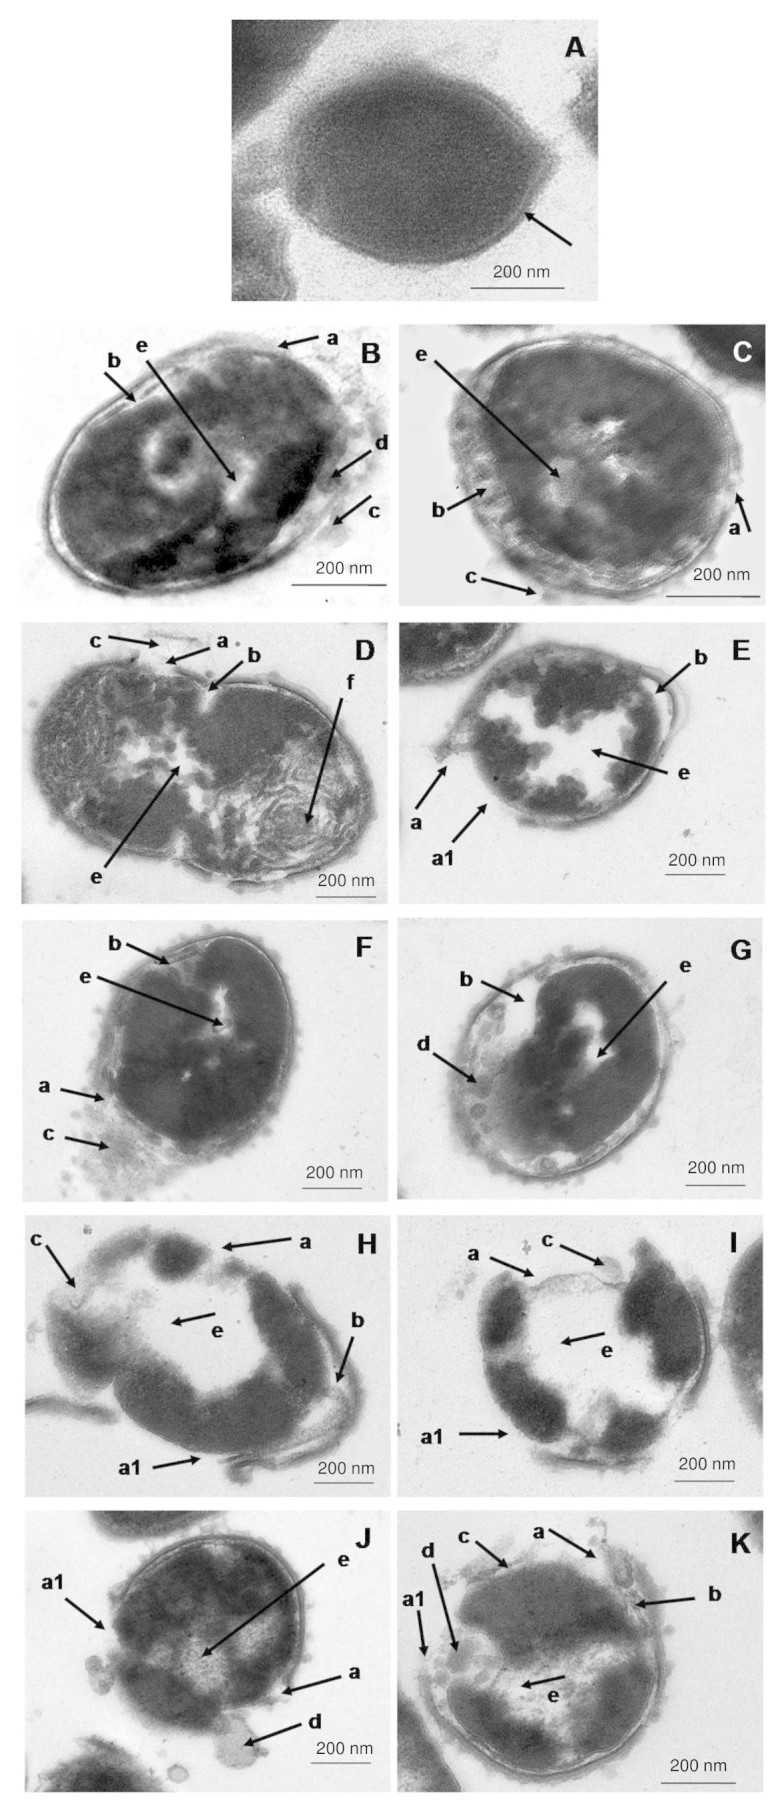
TEM images of PRSP treated with DM1 – DM5.(A) Untreated control showing the normal coccoidal shape of S. pneumoniae while severe cell morphological changes following treatment with (B & C) DM1, (D & E) DM2, (F & G) DM3, (H & I) DM4, and (J & K) DM5-treated pneumococcal cells were evident: (arrow a) cell wall/membrane breakages, (arrow a1) loss of cell wall, (arrow b) large cavity between cell wall and plasma membrane, (arrow c) leakage of intracellular contents, (arrow d) breakdown of cytoplasm into inclusion bodies, (arrow e) loss of cytoplasm, and (arrow f) filamentation of intracellular contents. Bar indicates 200 nm.